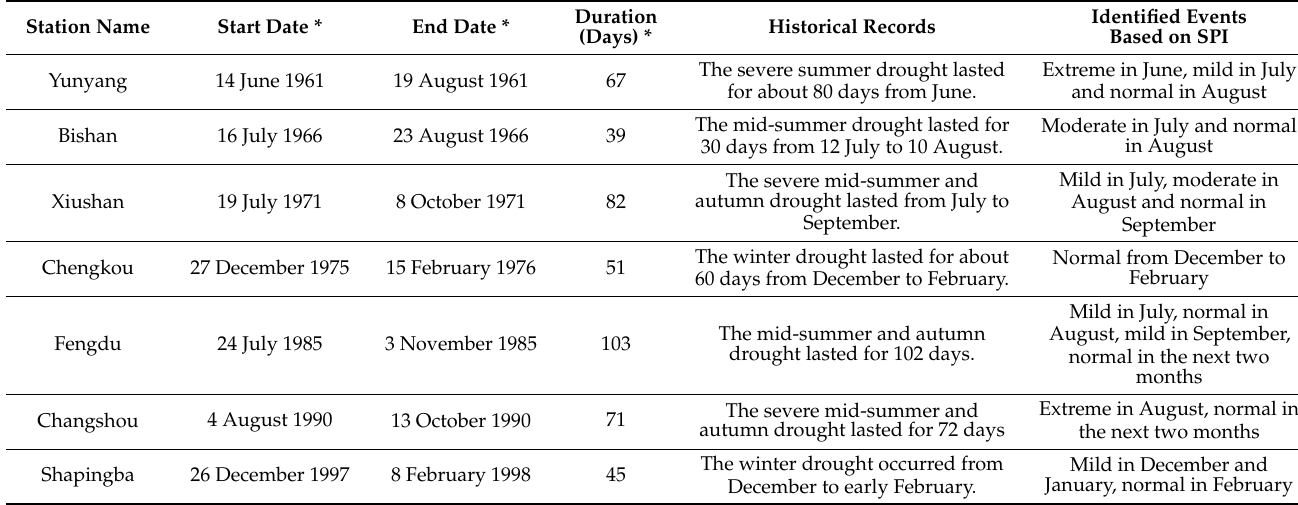
Table 3. Identification of typical drought events and the corresponding historical records in Chongqing during from 1960 to